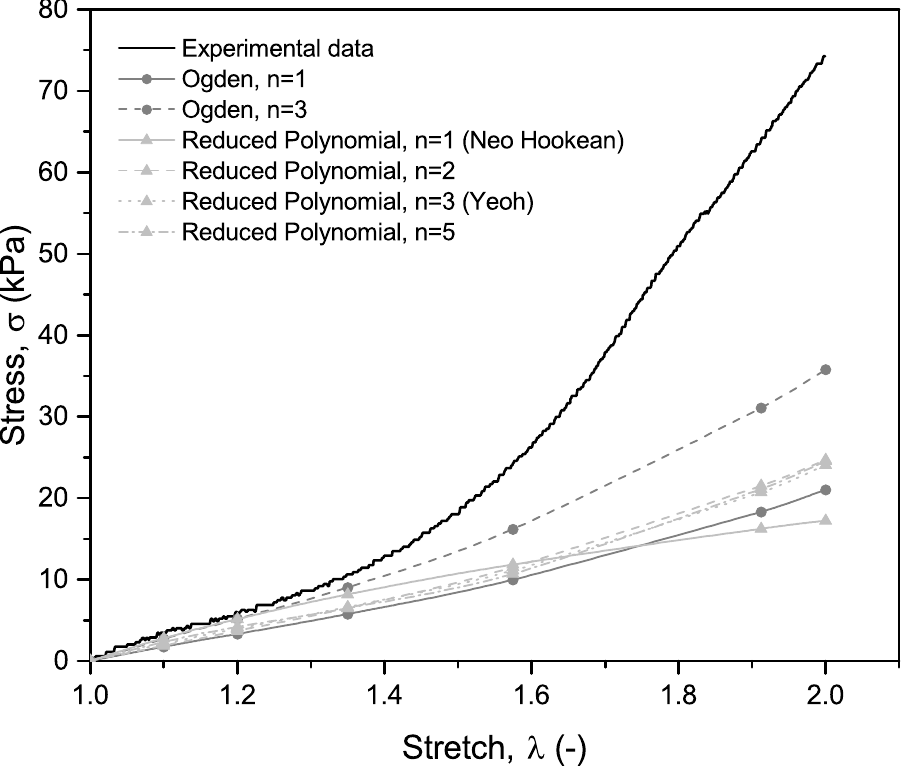
Figure 11. Comparison of circumferential experimental mean curve (last tensile cycle) and FEM